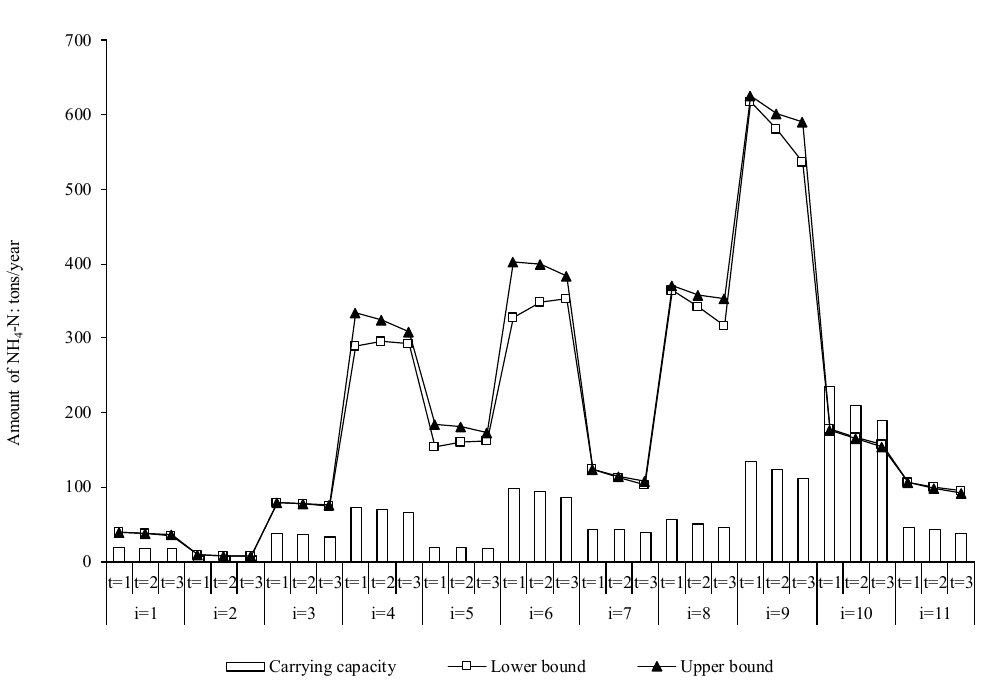
Figure 8. Relationships between carrying capacity of NH 4 -N and quantity inlets to the Yinma River.